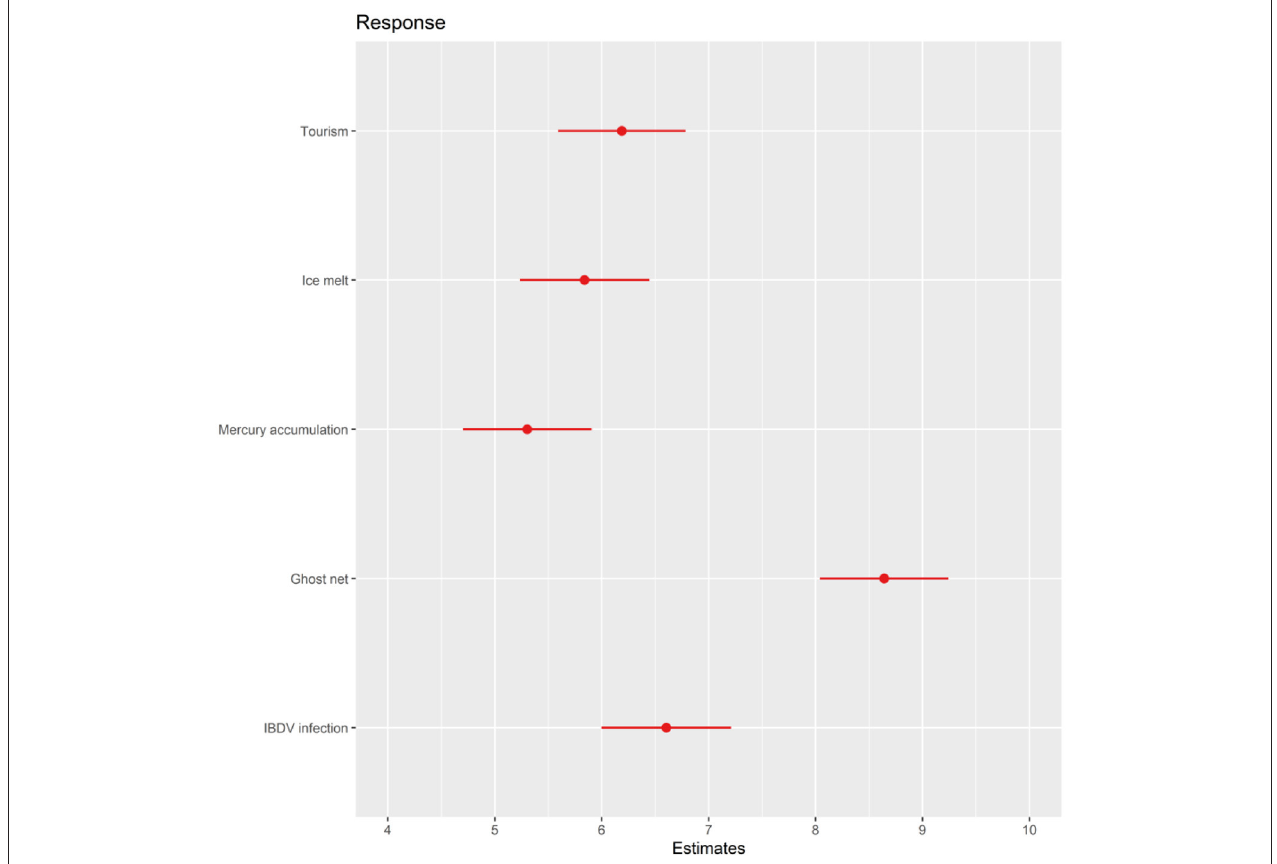
FIGURE 3 | Parameter estimates and 95% Wald confidence intervals for the response scores given for mental state for each